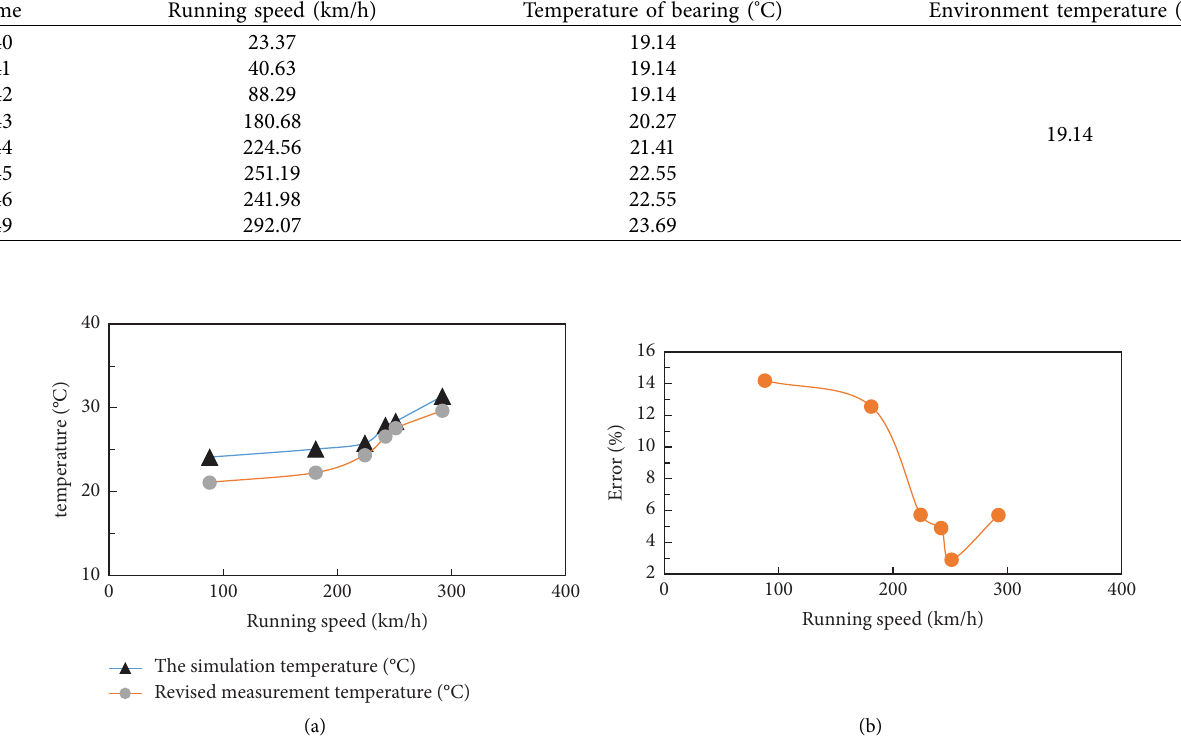
Table 4: Te measured speed of high-speed train and bearing temperature.